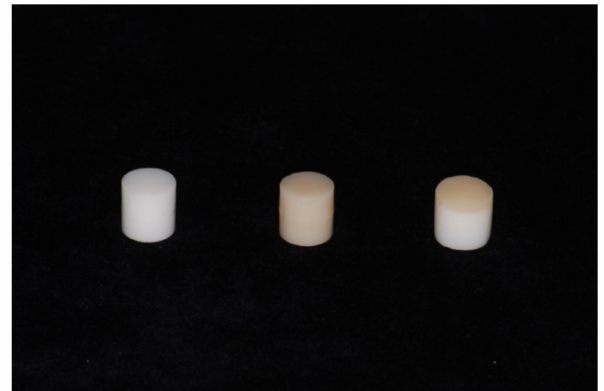
Figure 1. Metal-free